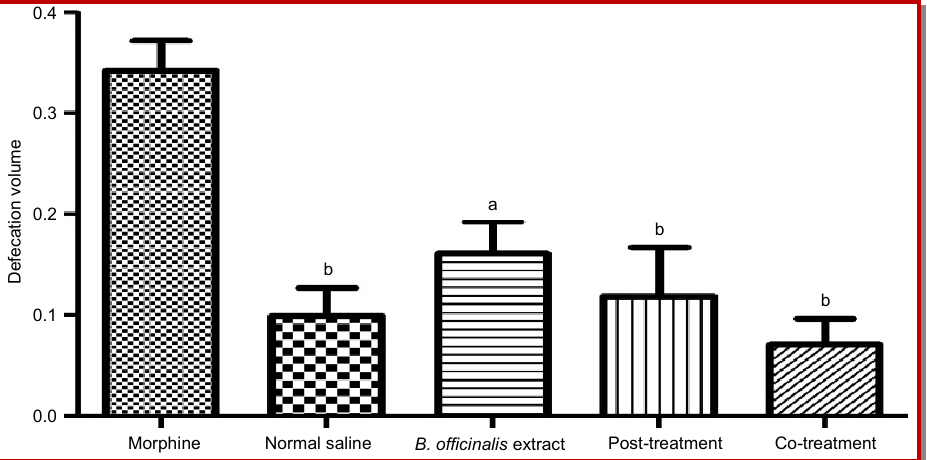
B. officinalis Figure 3: The effect of Borago officinalis extract injection, as post-treatment and co-treatment, on the amount of diarrhea after nalox- one injection in morphine-dependent mice; a p=0.01-0.05; b p<0.05